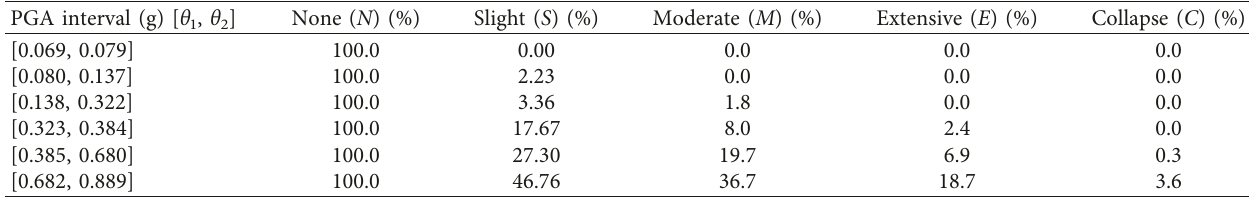
Figure 5: Calculated certainty measure, cert � 8%, and possibility measure, pos � 100%, of the set M � { d [0.323, 0.384]g. Table 5: Certainty measure of damage sets in equation (16) using equation (12) based on the possibility distribution in Figure 4.